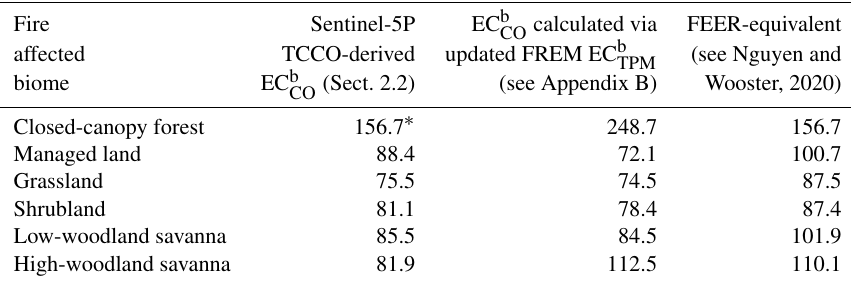
in gMJ − 1 ) as derived from the data shown in Fig. 2. Also shown are CO values from Appendix B and FEER-equivalent coefficient values produced TPM values shown in Appendix B are included to demonstrate the impact of using a TPM . CO